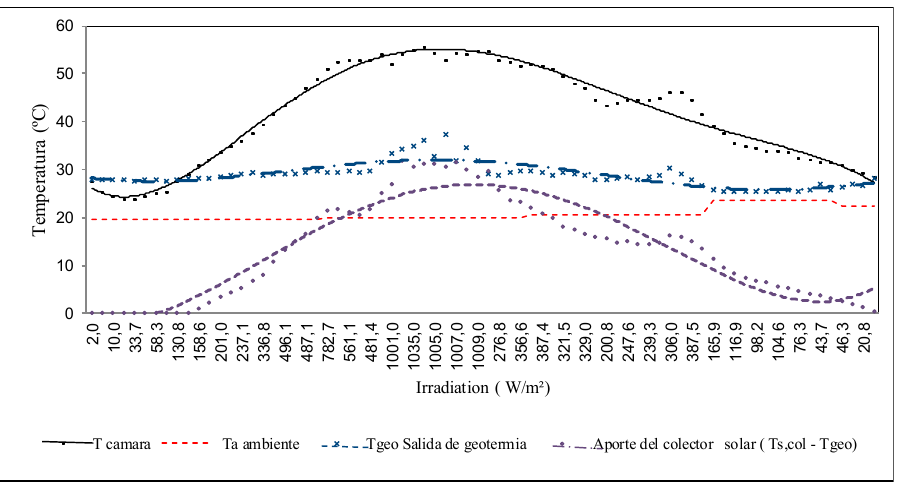
Figure 7. Operation of the solar dryer and the aerothermal system.